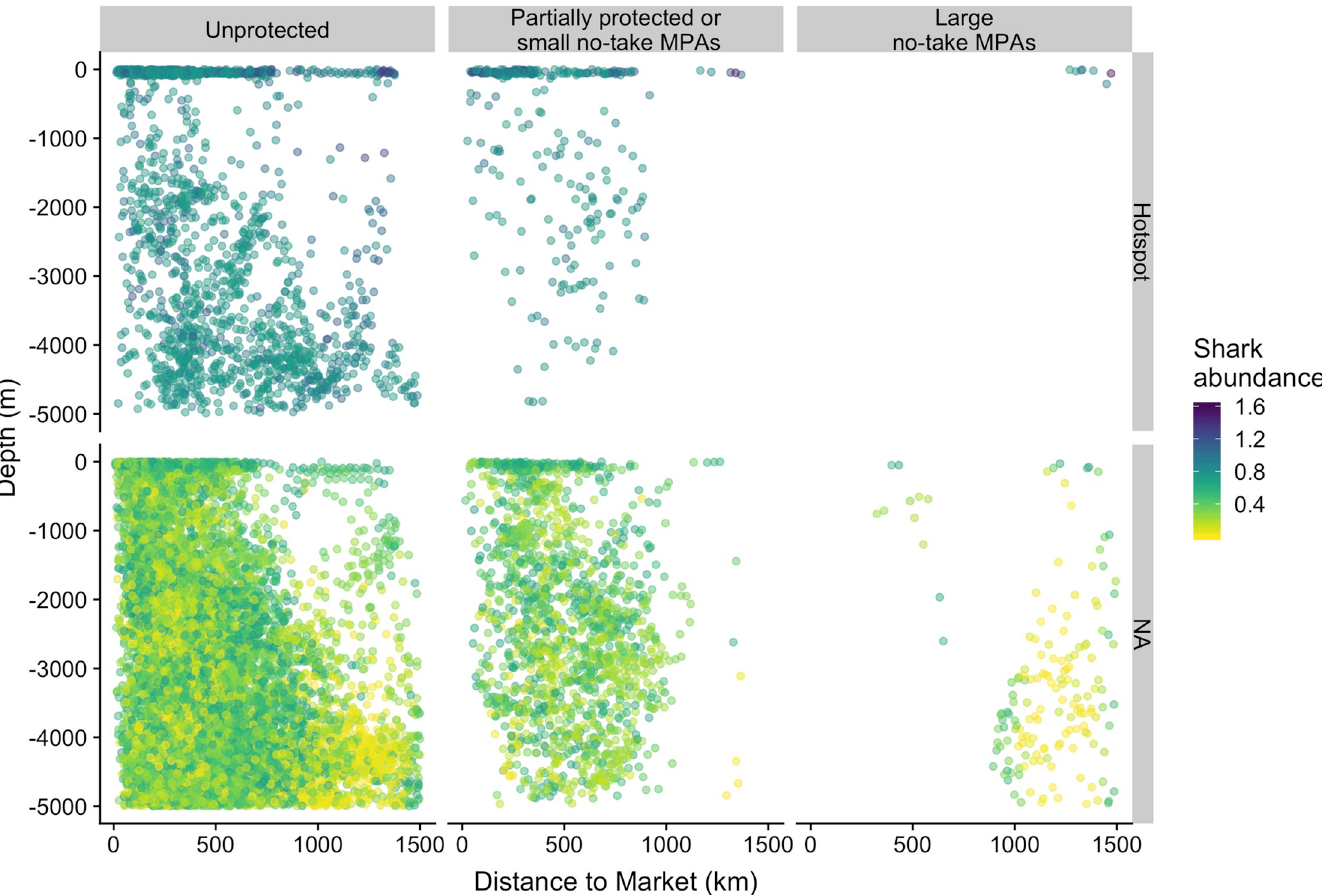
Fig 7. Predicted shark abundance and occurrence along a gradient of human pressures (Distance to Market) and habitat suitability (Depth). Values are segregated according to protection levels and whether they are hotspots ( > .95 quantiles) or not (NA).